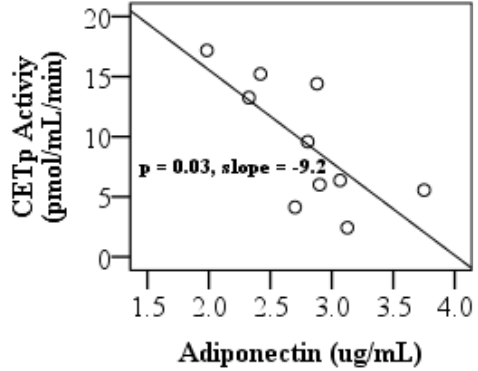
Figure 3. The negative relationship between adiponectin and cholesteryl ester transfer protein activity. Only in the type II diabetes group, adiponectin predicted cholesteryl ester transfer protein activity (slope CI [ − 15.9, − 1.8]).